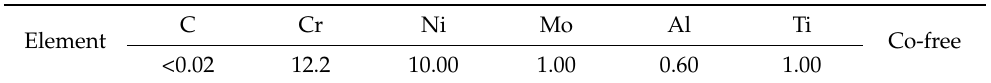
Table 1. Chemical composition of the M789 maraging steel powder in units of wt% (provided by the